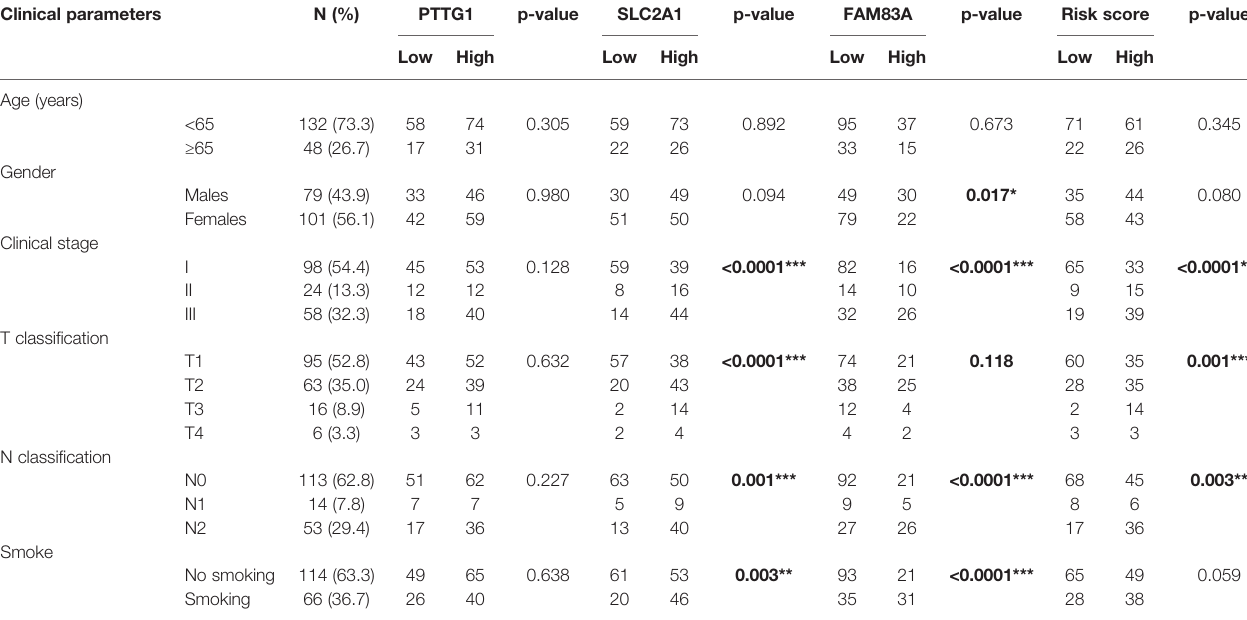
TABLE 1 | Clinical parameters and their association with the risk score in the Tianjin cohort. Clinical